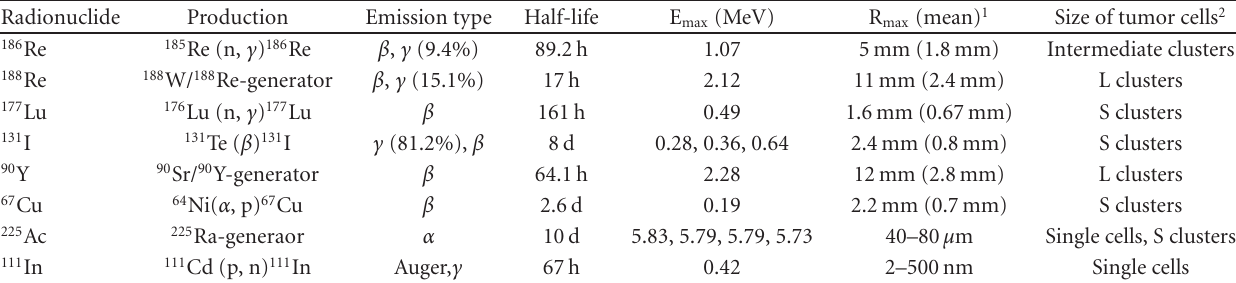
Table 2: Characteristics of potential radionuclides for tumor radiotherapy [14, 15, 19–21, 54, 55].